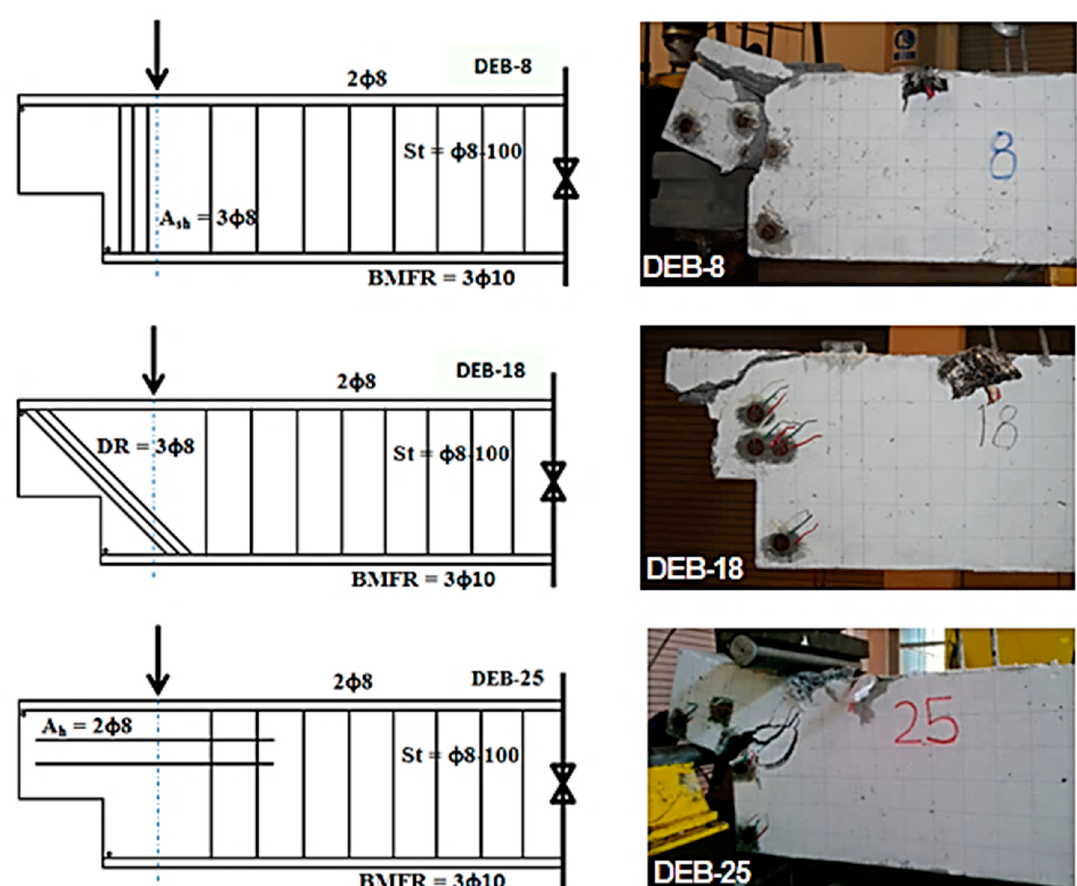
Figure 8. Reinforcement detail and modes of failure of DEB-8, DEB-18, and DEB-25.